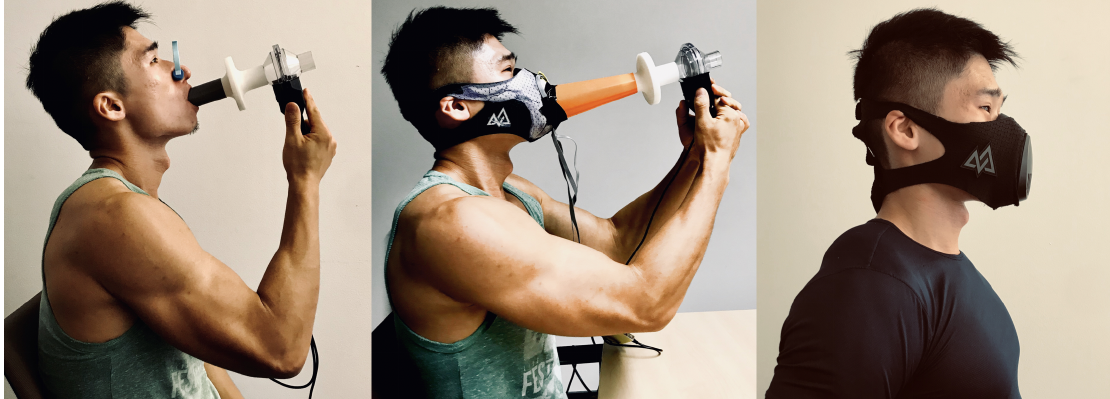
Figure 10. ( Left ) a participant performing a standard clinical forced vital capacity (FVC) test. ( Center ) a participant performing The FVC test with The calibration system. ( Right ) our proposed smart mask functions without extra instrument. Note that our instrument is fully integrated with a standard sports mask routinely used by athletes to control air inflow during exercise without making The mask in any way more